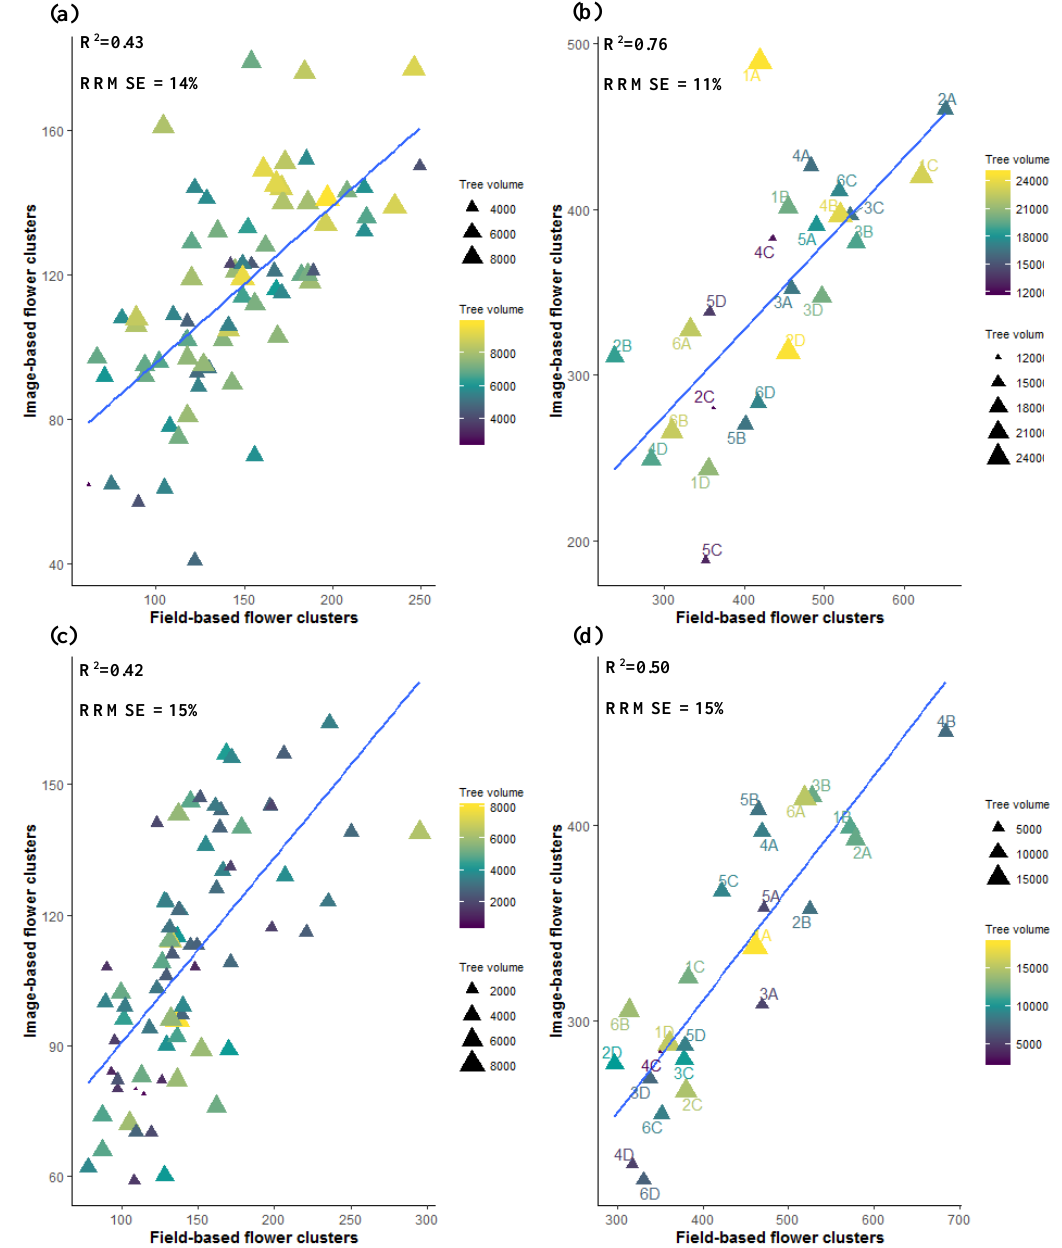
Figure 3. Linear correlation between the field-based flower clusters (FC) and the image-based flower clusters (FC*) for ( a ) Rummen on individual tree level, ( b ) Rummen on plot level, ( c ) Wimmertingen on individual tree level, ( d ) Wimmertingen on plot level; the tree volume in cm 3 is visualized by the symbol size and color of the datapoints.